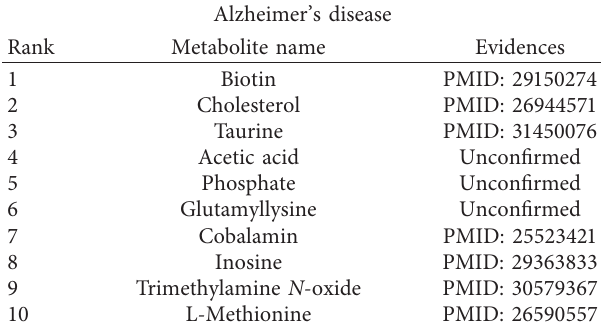
Table 6: Candidate metabolites of Alzheimer’s